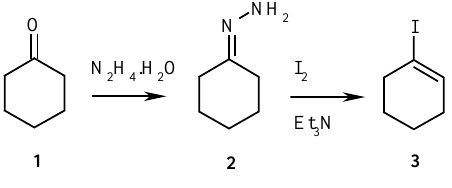
= 254 nm; t = 60 min) IR IR